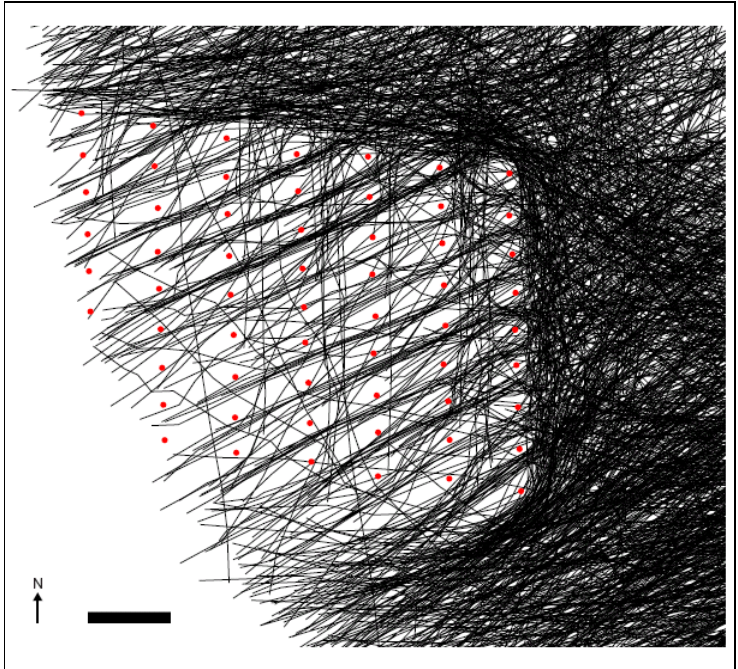
Figure 5. The south-west flight paths of autumn-migrating waterbirds at the Nysted wind farm, Denmark. Red dots indicate individual turbines and black lines migrating waterbird flocks